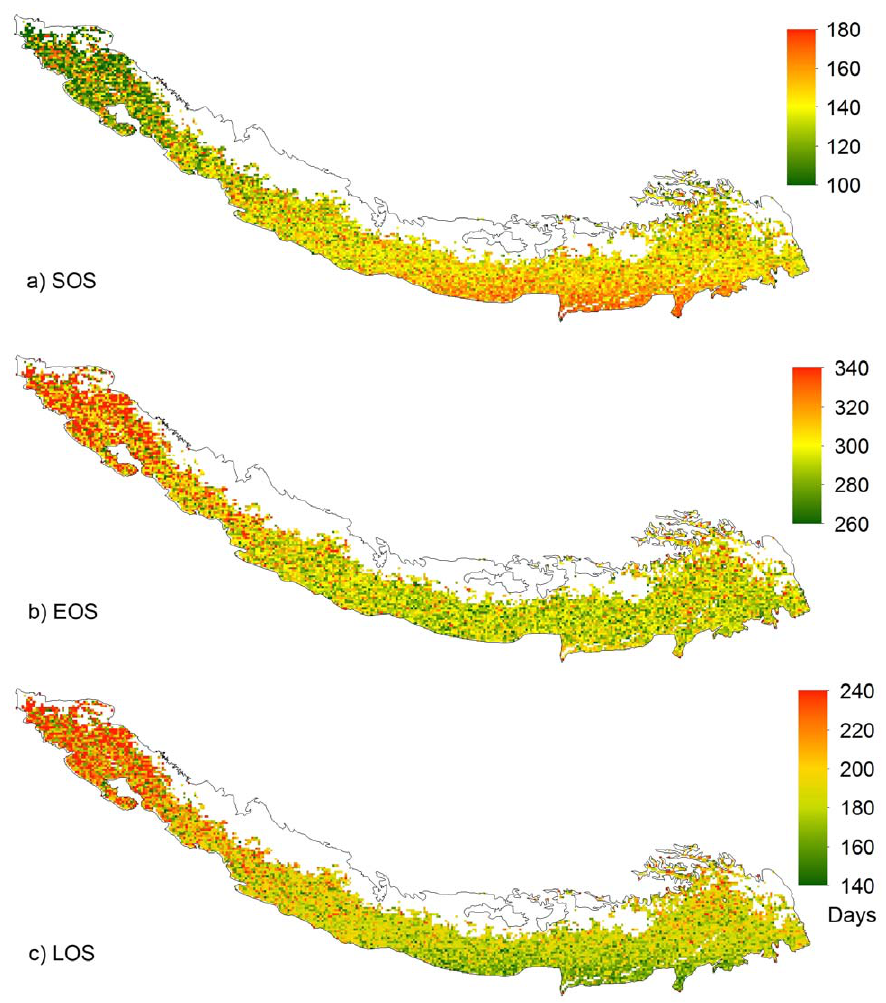
Figure 3. Spatial distribution of 25 year average SOS, EOS and LOS in the Himalayas.